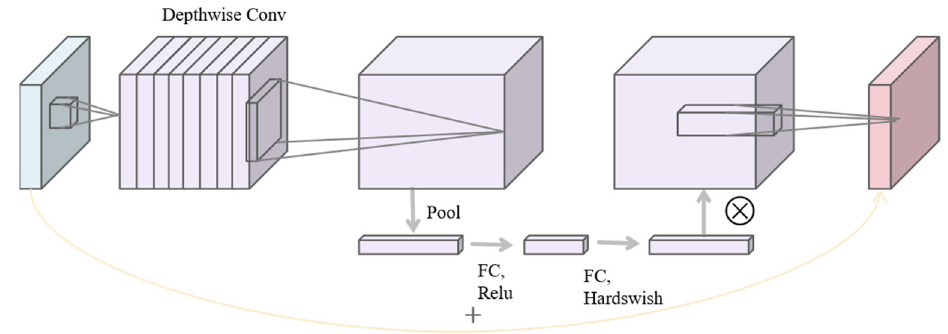
Figure 3. Schematic diagram of the BNeck structure.